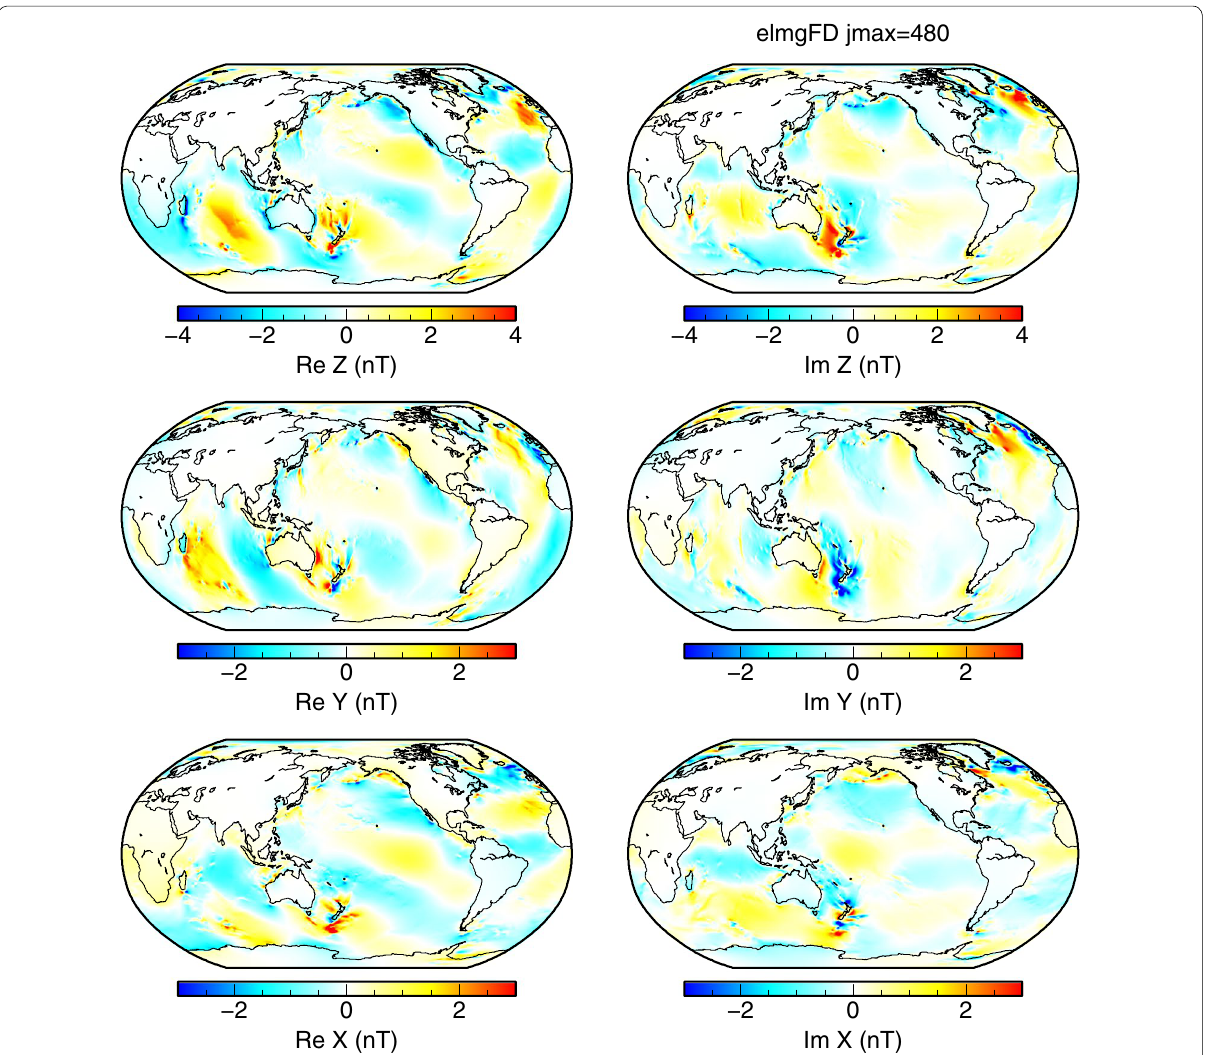
Fig. 4 Magnetic signatures of M 2 tides. The real (left column) and the imaginary (right column) parts of the three magnetic field components at the Earth’s surface calculated using the elmgFD code with 2-D surface conductance and forcing at the highest lateral resolution, j max = 480 . Note the use of different colour scales for vertical and horizontal